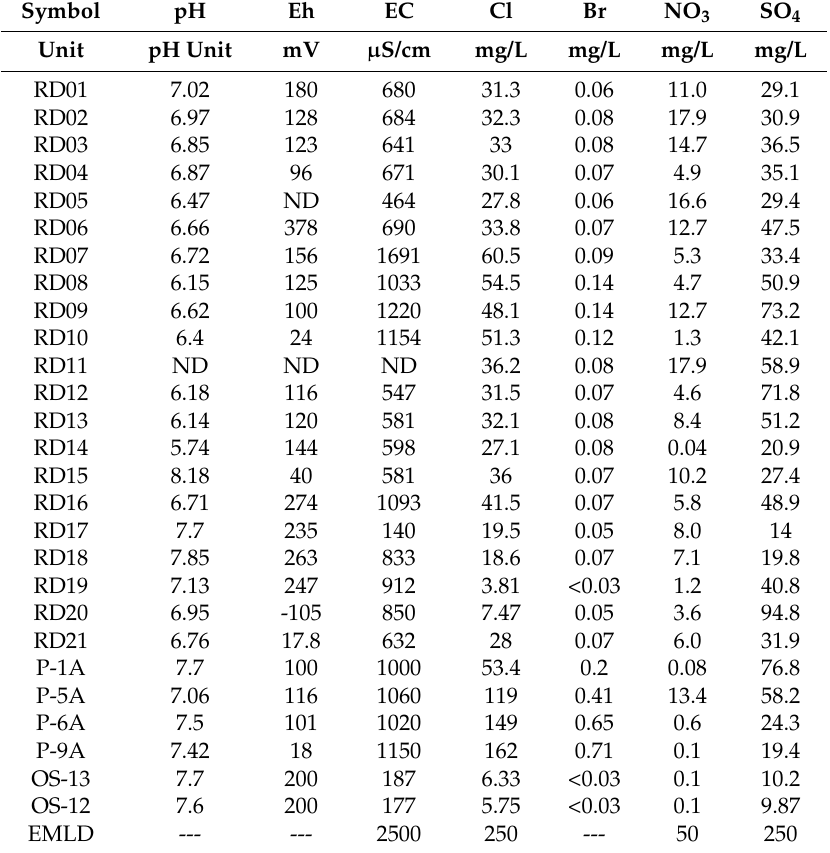
Table 3. Main anion contents of water